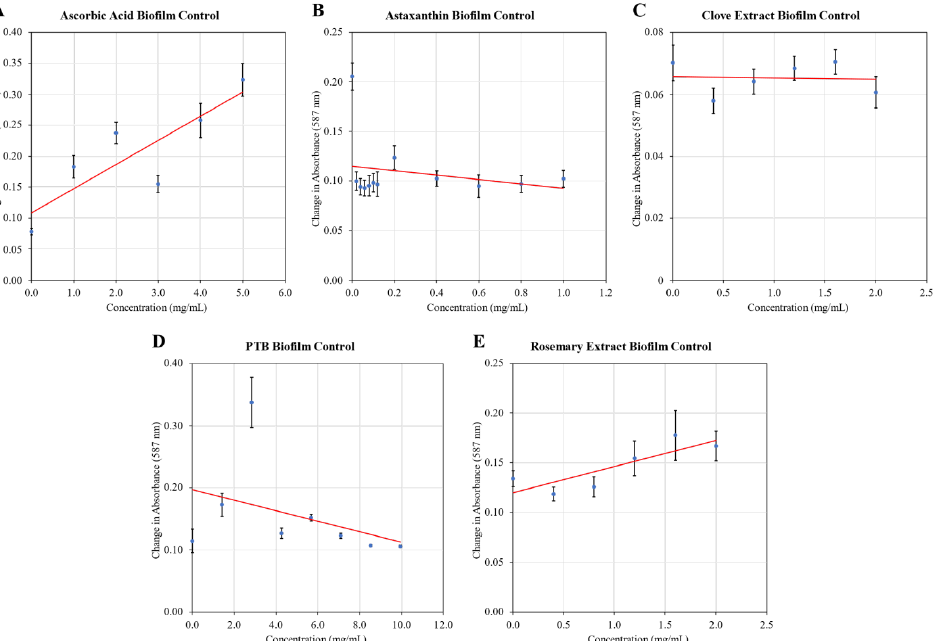
Figure A3. Effects of test compounds on biofilm formation in the absence of glucose-keratin induced biofilm formation. ( A ) Ascorbic acid: y =0.039x + 0.11, R 2 = 0.72, p =0.32. ( B ) Astaxanthin: y = −0.0003x + 0.10, R 2 = 0.0001, p = 0.97. ( C ) Clove extract: y = −0.0004x + 0.066, R 2 = 0.0036, p = 0.91. ( D ) PTB: y −0.0085x + 0.20, R 2 = 0.15, p = 0.35. ( E ) Rosemary extract: y = 0.026x + 0.12, R 2 = 0.70, p = 0.039. n = 8. Mean ± standard deviation.